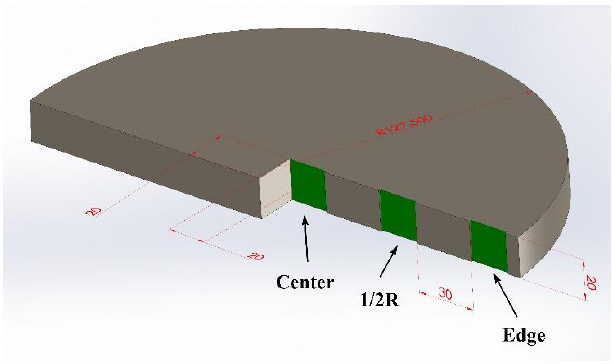
Figure 2. Schematic illustration of the positions of specimen taken from billets.